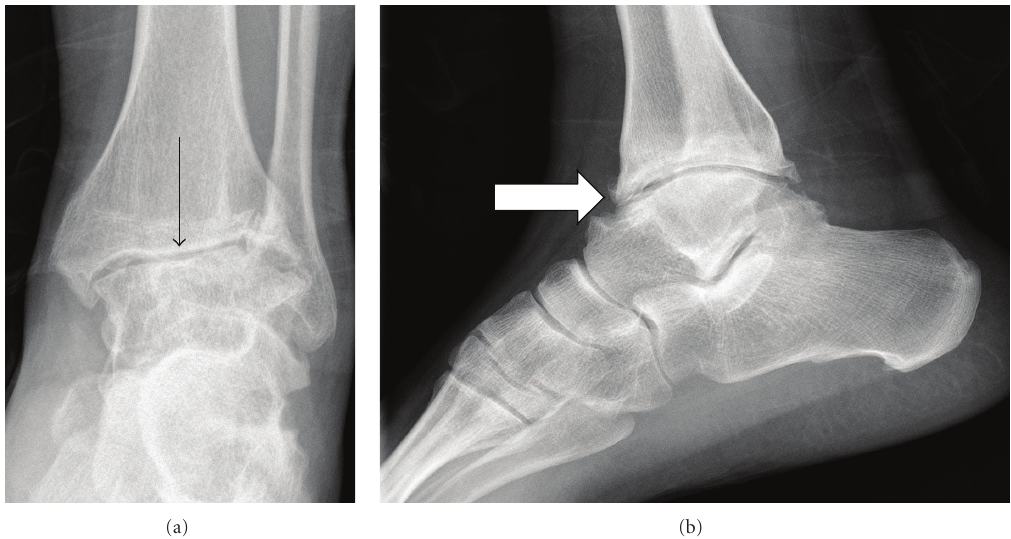
Figure 3: Hemophilic arthropathy of the ankle (black arrow) in the AP (a) and lateral (white arrow) radiographs (b).